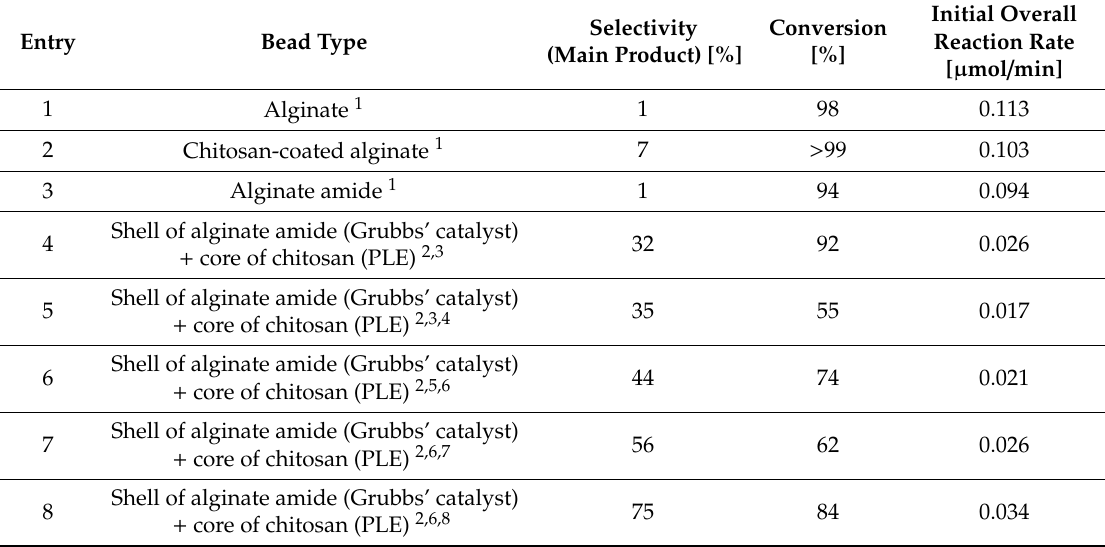
Table 2. Co-encapsulated catalysts in multicompartment beads enhanced the selectivity. Further enhancement was achieved by increasing the bead